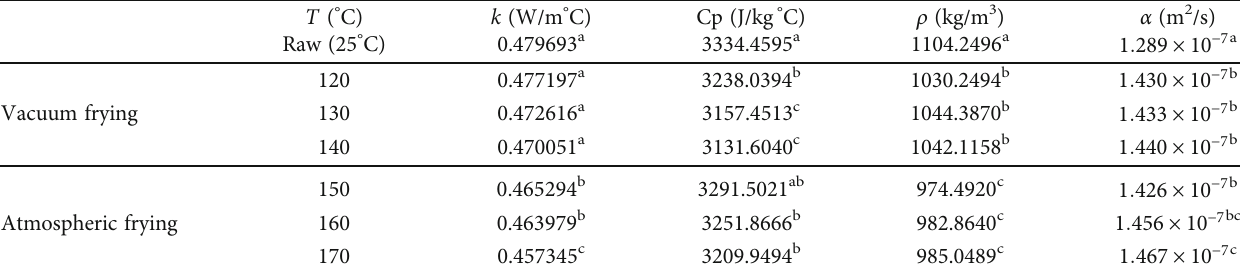
Table 4: Thermophysical properties of Carimañolas fried under vacuum and atmospheric conditions. T ( °